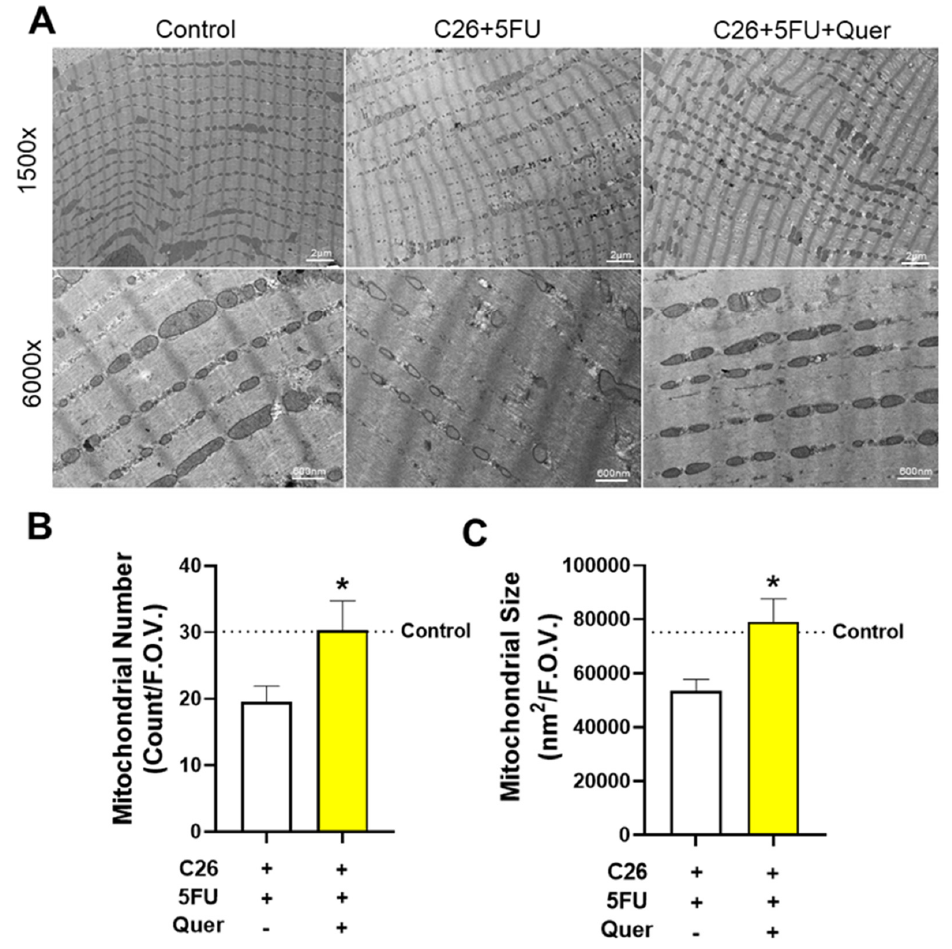
Figure 3. Quercetin increased mitochondrial size and number. ( A ) Representative transmission electron microscopy images of the soleus muscle taken at 1500 × and 6000 × . ( B ) Average number of mitochondria per field of view (F.O.V.) from 6000 × images. ( C ) Average size in nanometers 2 (nm 2 ) of mitochondria per F.O.V. n = 3/group. 1500× scale bar — 2 μ m. 6000× scale bar — 600 nm. Unpaired t ‐ test between C26 + 5FU and C26 + 5FU + Quer. n = 3/group * p ≤ 0.05.